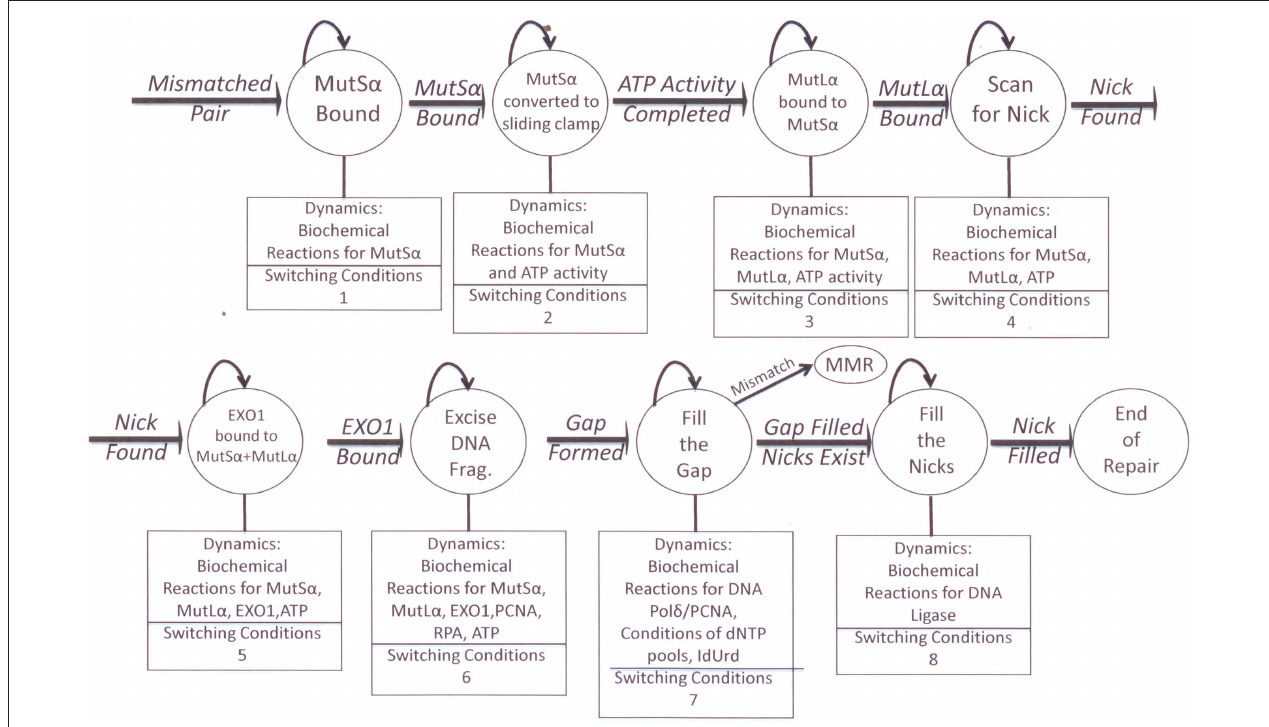
Figure 4 | Modeling framework: hybrid model human DNA